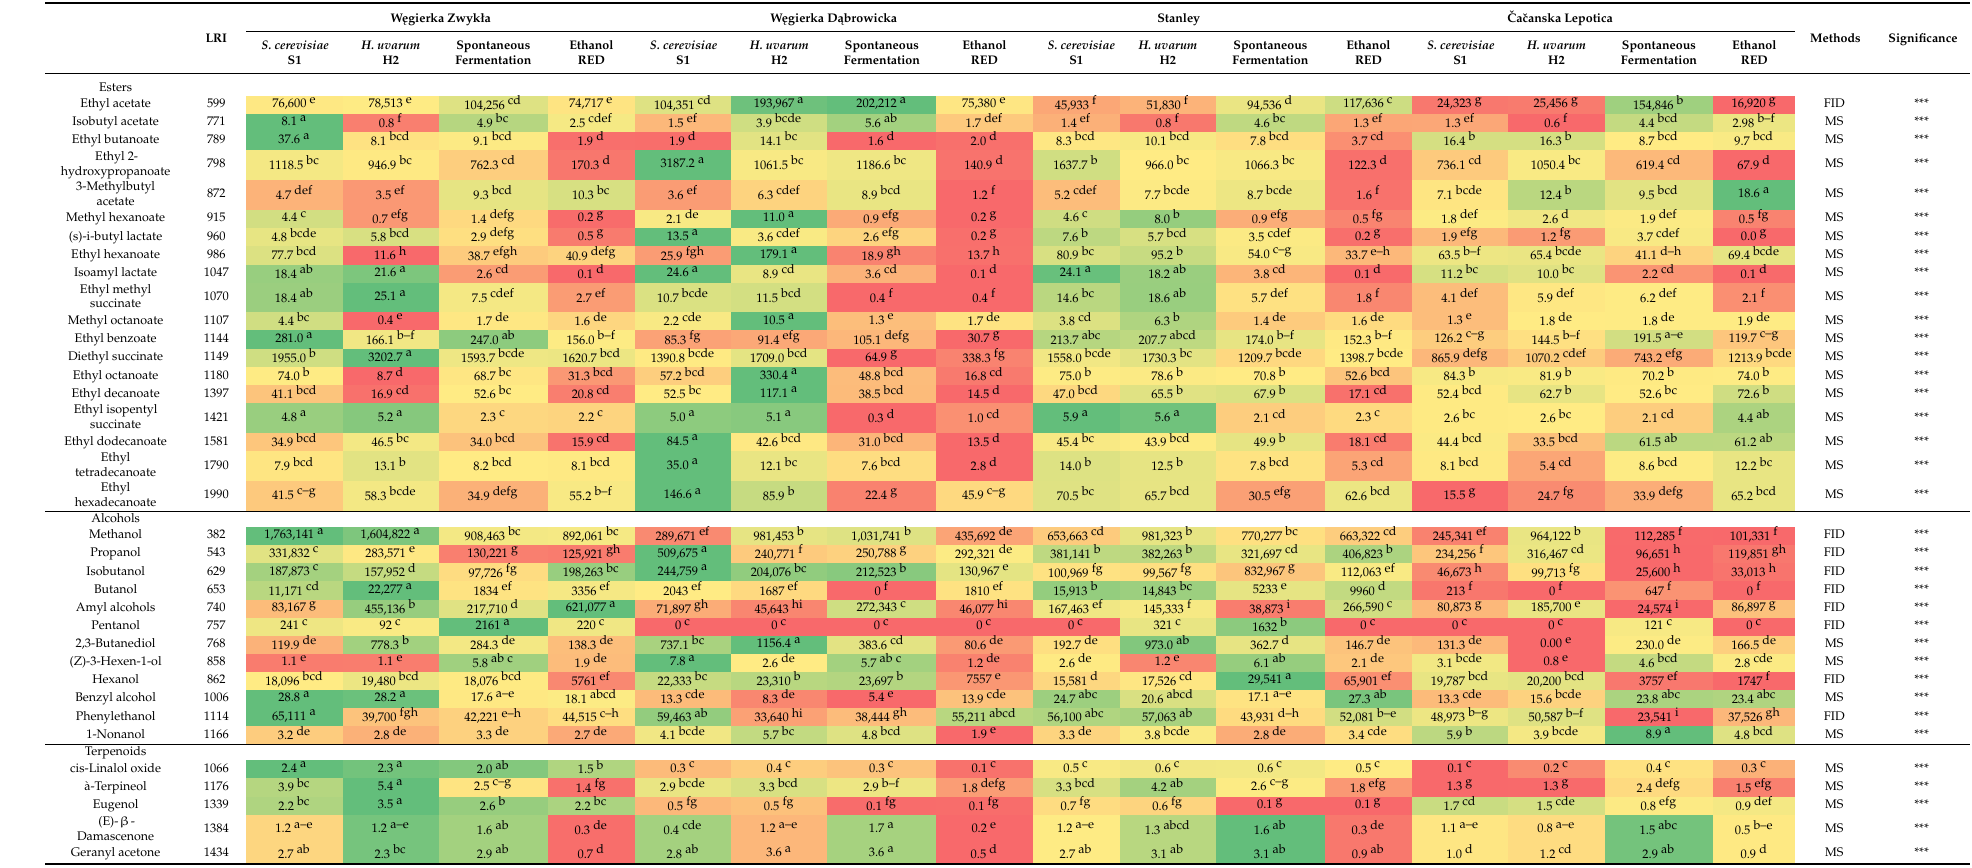
Table 5. Aroma composition of plum jerkums [ µ